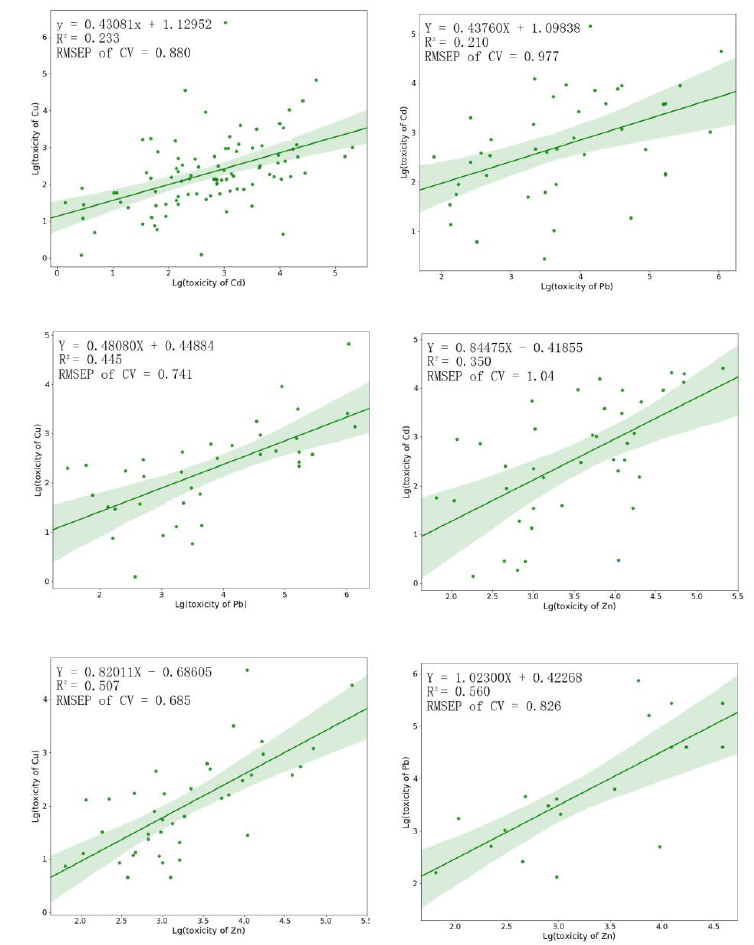
Figure 3. The toxicity prediction models for each pair of the four heavy metals. Table 4. External verification of the prediction models using observed data in the present study.